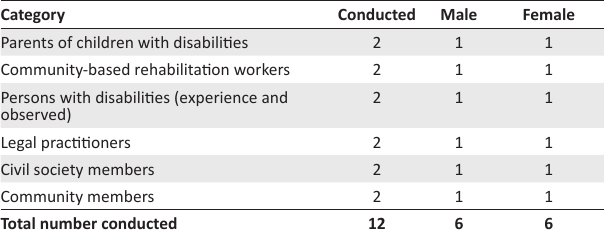
TABLE 2: Characteristics of key informants interviewed in the in-depth